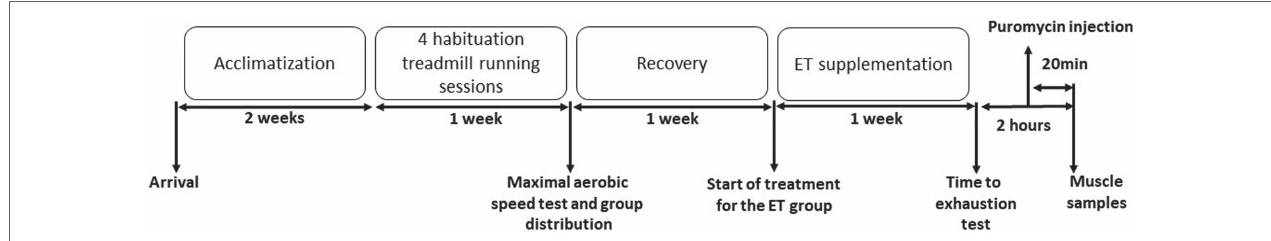
FIGURE 1 | Experimental protocol. Mice were acclimatized to their cages for 2 weeks, before undergoing four treadmill running habituation sessions. One week before supplementation initiation, the maximal aerobic speed (MAS) was measured by running on the treadmill. Then, mice were distributed in the control (Ctrl) and ergothioneine (ET) supplementation group according to their MAS. After 1 week of ET supplementation (or not for the Ctrl group), mice performed a time to exhaustion test at 70% of their individual MAS. Puromycin was injected 100 min after the test end and muscles were collected after sacrifice at 120 min after the exercise